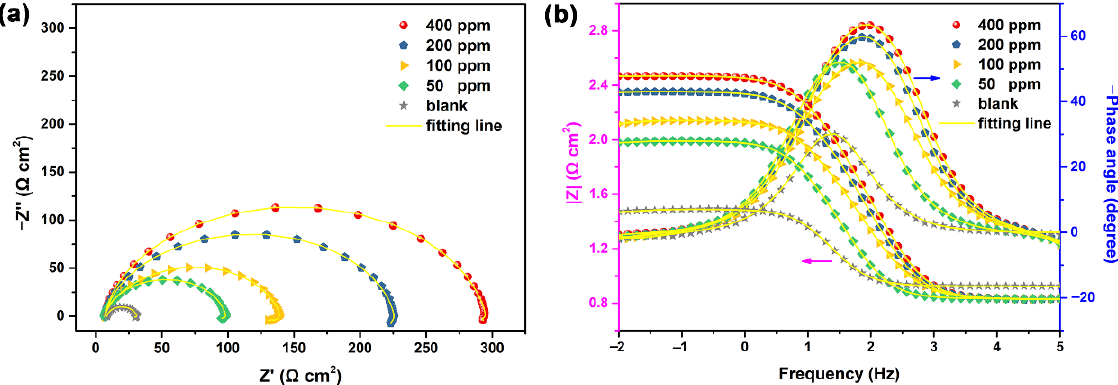
Figure 4. The EIS results of Q235 carbon steel in 1 M HCl solution in the absence and presence of different concentrations of NCDs, ( a ) Nyquist plots and ( b ) Bode plots.